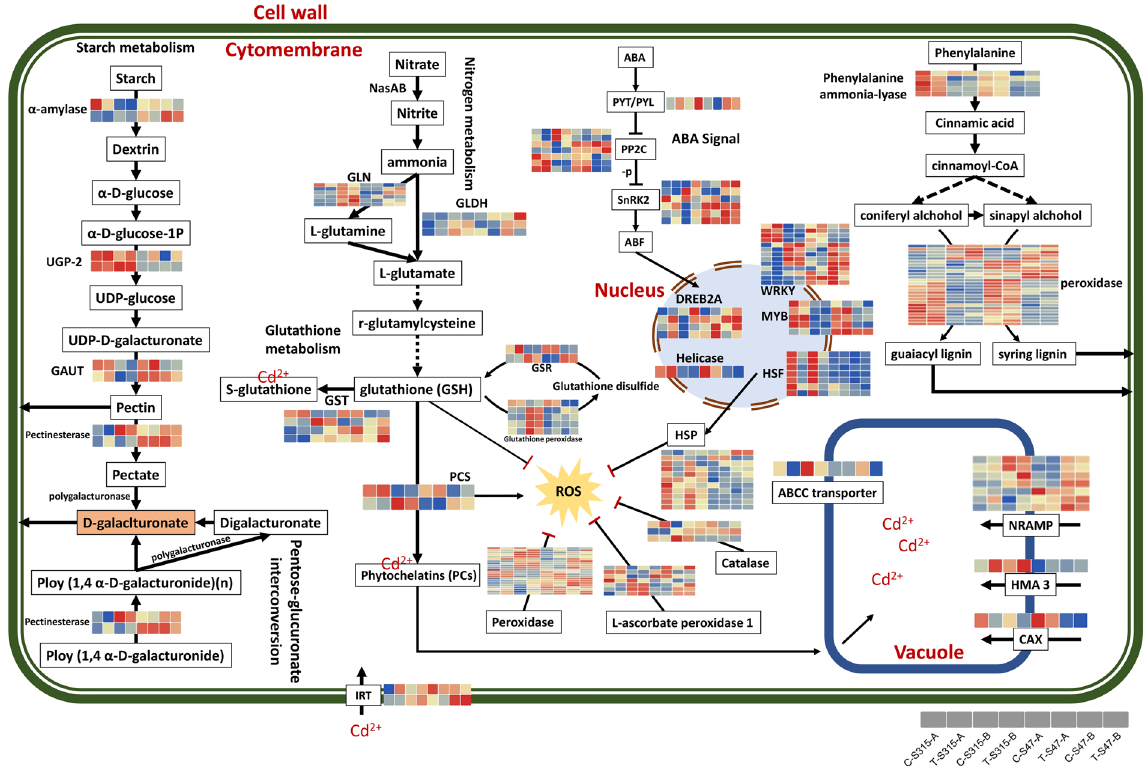
Figure 2. The expression patterns of DEGs response to Cd stress in different groups. Heatmaps shows the expression level of DEGs, and the redder the color, the higher expression. Original figure is from Zhou’s report, and modified according to our results. Original figure from: Zhou, Q. et al . Comparative transcriptome analysis between low-and high-cadmium-accumulating genotypes of pakchoi (Brassica chinensis L.) in response